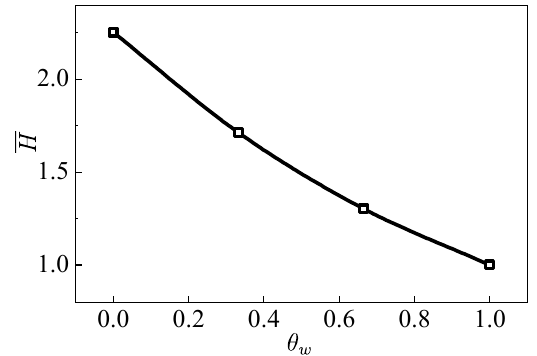
Figure 5. Dimensionless cross-section mean apparent viscosity ( 𝛨 ) at different temperature.